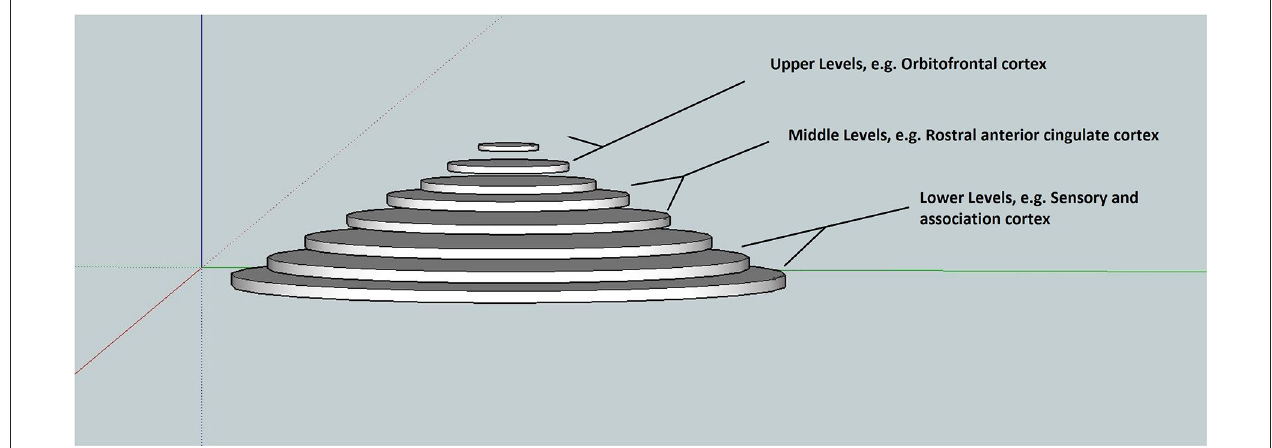
FIGURE 1 | An aligned memory residing simultaneously intra-hierarchically and inter-hierarchically . Lower hierarchical levels contain rich sensory representations such as color, texture, smell. Notice that the frontal cortices are located at the top and center.